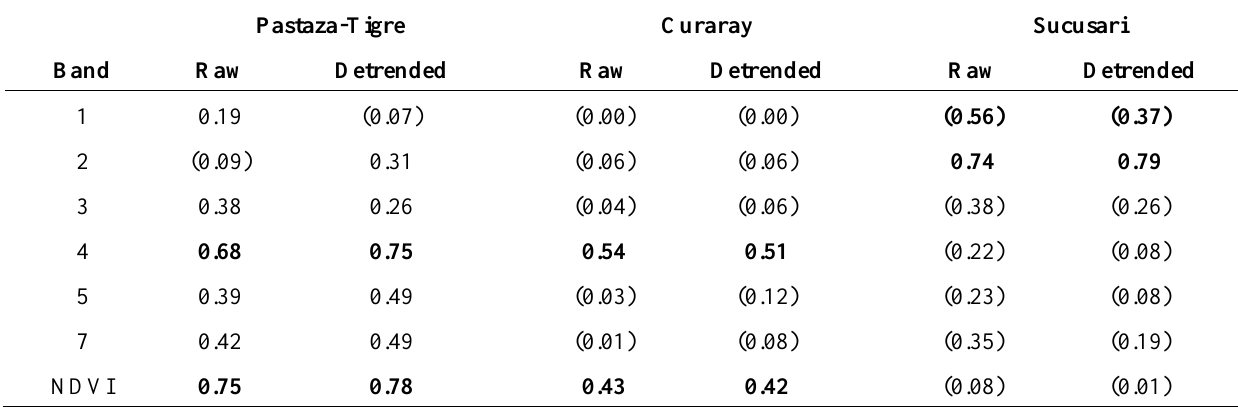
Table 2. Relationship between Landsat and soils data for three study areas in northern Peruvian Amazonia. Values are the coefficient of determination (r 2 ) for linear regressions between individual Landsat bands (measured by digital numbers or detrended digital numbers) or NDVI as independent variables, and the soil cation gradient (as measured by the log-transformed sum of the concentrations of Mg, Ca, Na, and K) as dependent variables, based on either unprocessed (“Raw”) or detrended (“Detrended”) Landsat images. All values are significant at P < 0.001, with the exception of values in parentheses. The two highest r 2 values for either each image are presented in